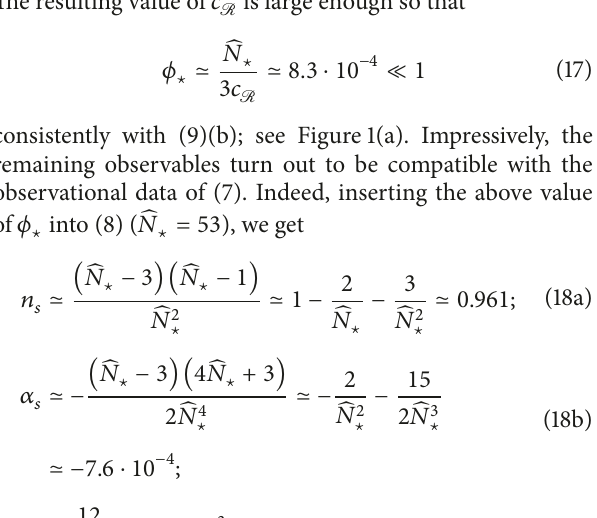
Figure 1: The inflationary potential also